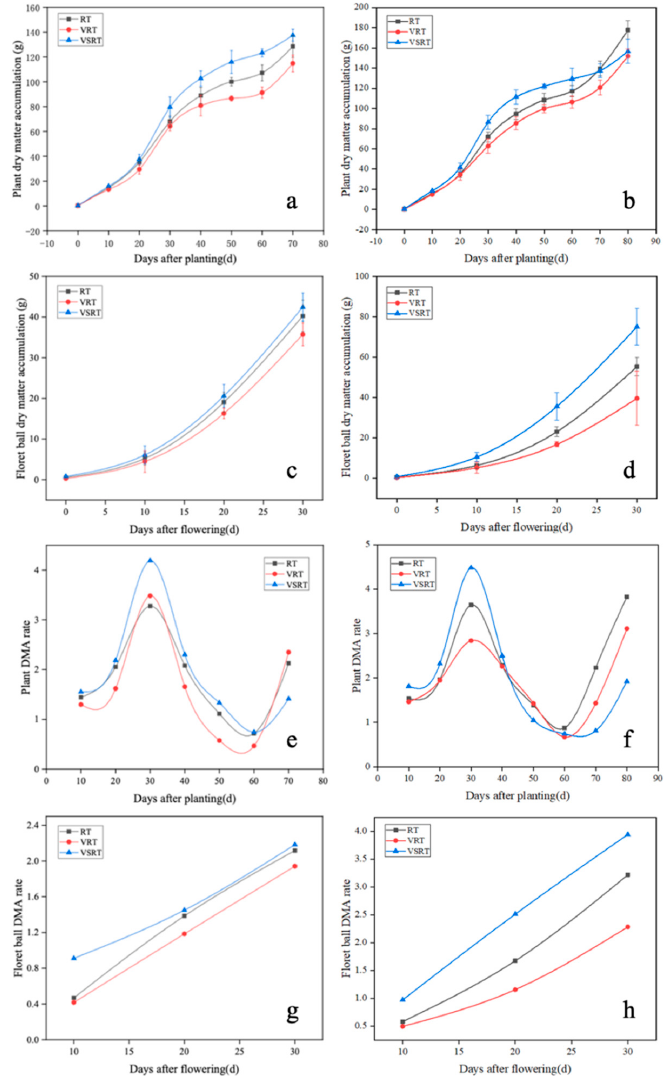
Figure 7. Dry matter accumulation (DMA) of broccoli plants and floret balls, and the DMA rate of broccoli plants and floret balls. ( a , c , e , g ) show values in 2020, and ( b , d , f , h ) show values in 2021. Rotary tillage, RT; vertical rotary tillage, VRT; vertical smashing rotary tillage, VSRT.